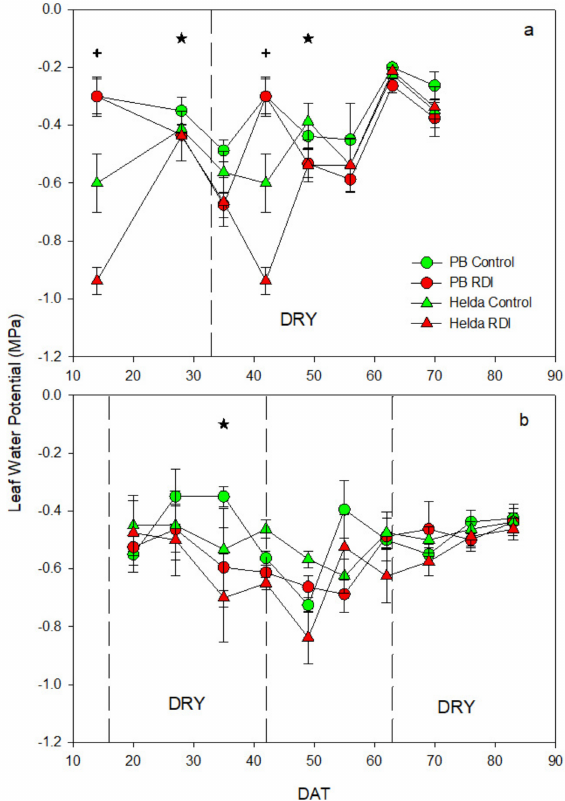
Figure 3. Pattern of midday leaf water potential during the 2020 ( a ) and 2021 ( b ) seasons. Each point is the average of 4 measurements. Vertical lines represent the standard error. Triangles, cv Helda (upside down, Control; upright, RDI); Circles, cv Perfeccion Blanca (red, Control; orange, RDI). Asterisks indicate significant differences on that date by irrigation treatment ( p < 0.05) and crosses are used for differences between cultivar ( p < 0.05). The word “dry” indicates a period without irrigation.